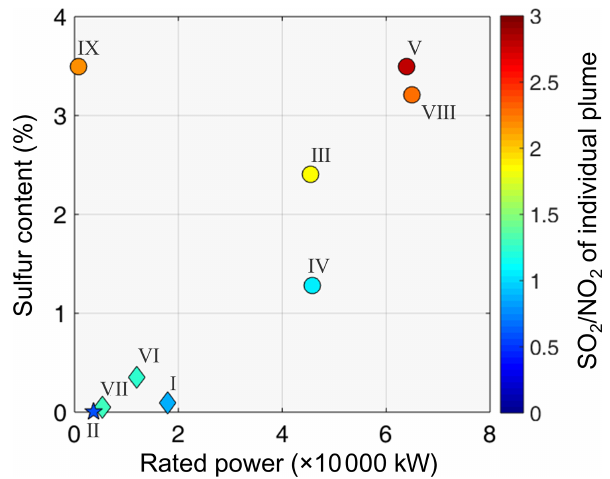
Figure 14. The relationship between the SO 2 / NO 2 ratio and the fuel sulfur content and engine rated power of all nine vessels, ob- tained by linear regression. Tugboats, and inbound and outbound vessels are represented by a star, diamonds and circles,